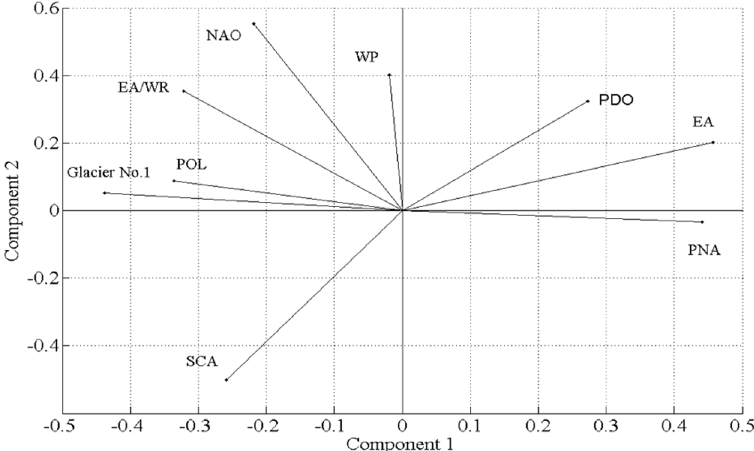
Figure 3. Biplot from the first two modes of PCA.